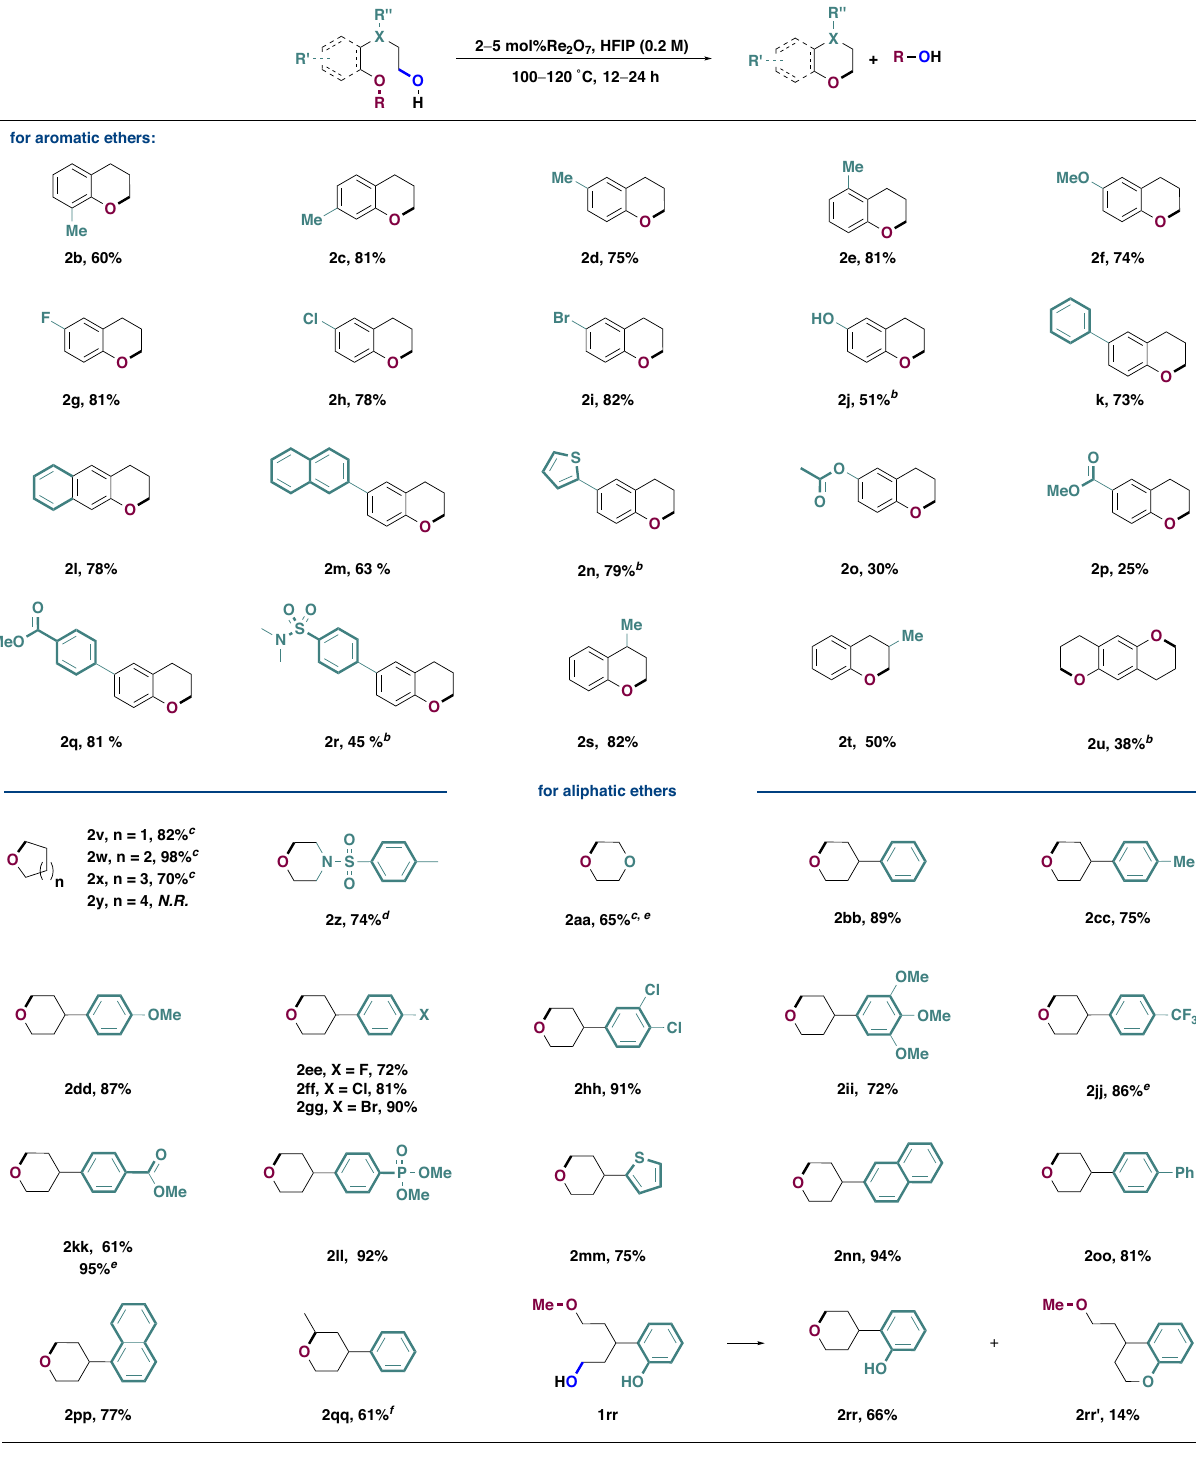
otherwise. b 3 mol% Re 2 O 7 , 120°C, 24h. c Yields were determined by analyzing 1 H NMRofthereactionmixturewithaninternalstandard. d 4mol%Re 2 O 7 ,120°C,24h. e 5 mol% Re 2 O 7 , 120°C, 24h. f 2 mol% Re 2 O 7 , 80°C,